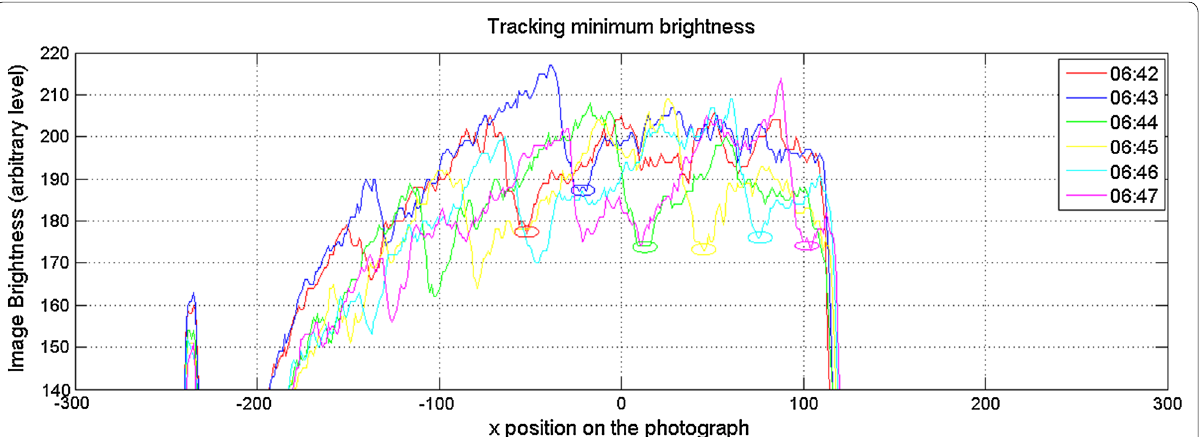
Fig. 14 Brightness of the photograph along the cross section shown by the red dotted line in Fig. 12 from 0642 LT to 0647 LT. The circles indicate the selected positions on the image used for calculating the phase velocity of the KH